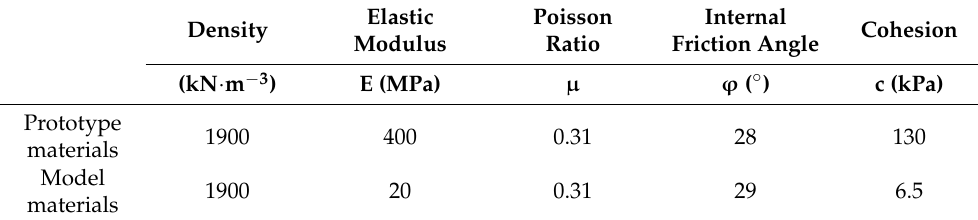
Table 3. Physical and mechanical parameters of surrounding rock